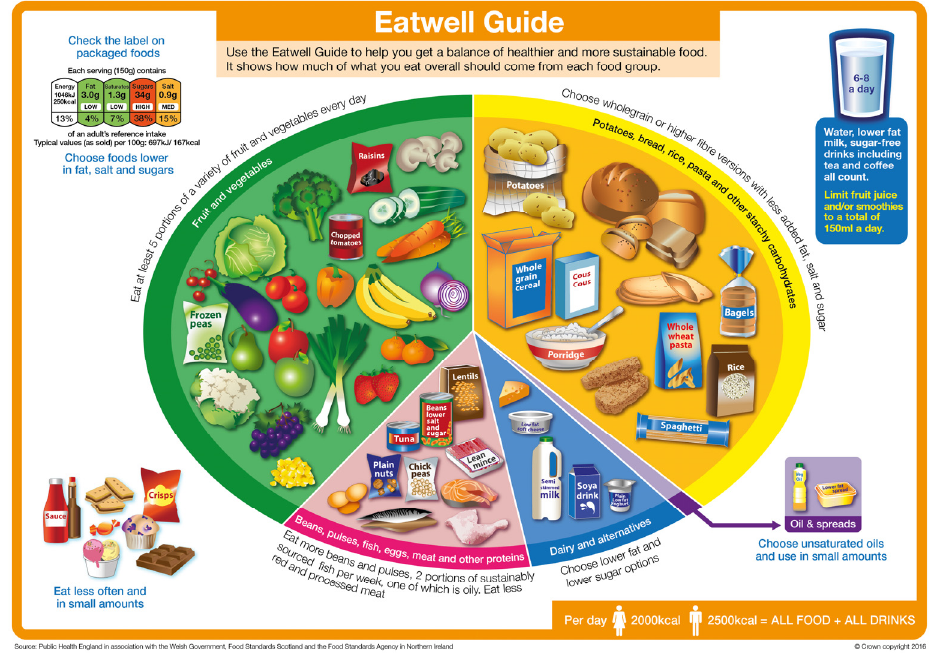
Figure 1. The Eatwell Guide. The UK National Food Model Updated from the eatwell plate in March 2016.